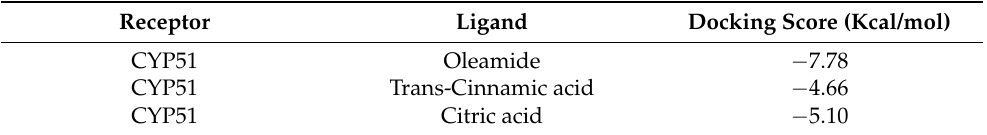
Table 2. The molecular docking scores of lanosterol 14 α -demethylase (CYP51) with oleamide, trans- cinnamic acid, and citric